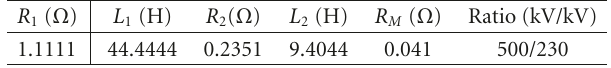
Table A.3: Parameters of a three-phase transformer of test system 1.